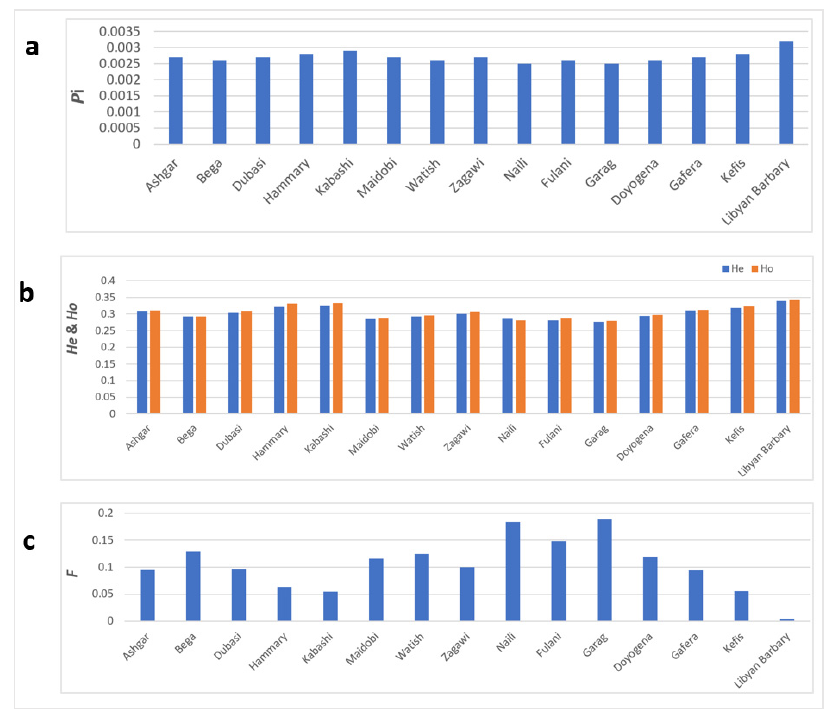
Figure 4. Genetic diversity parameter estimates for each of the 15 sheep populations analyzed: ( a ) Nucleotide diversity ( Pi ), ( b ) expected heterozygosity ( He ); observed heterozygosity ( Ho ) and ( c ) the inbreeding coefficient ( F ).